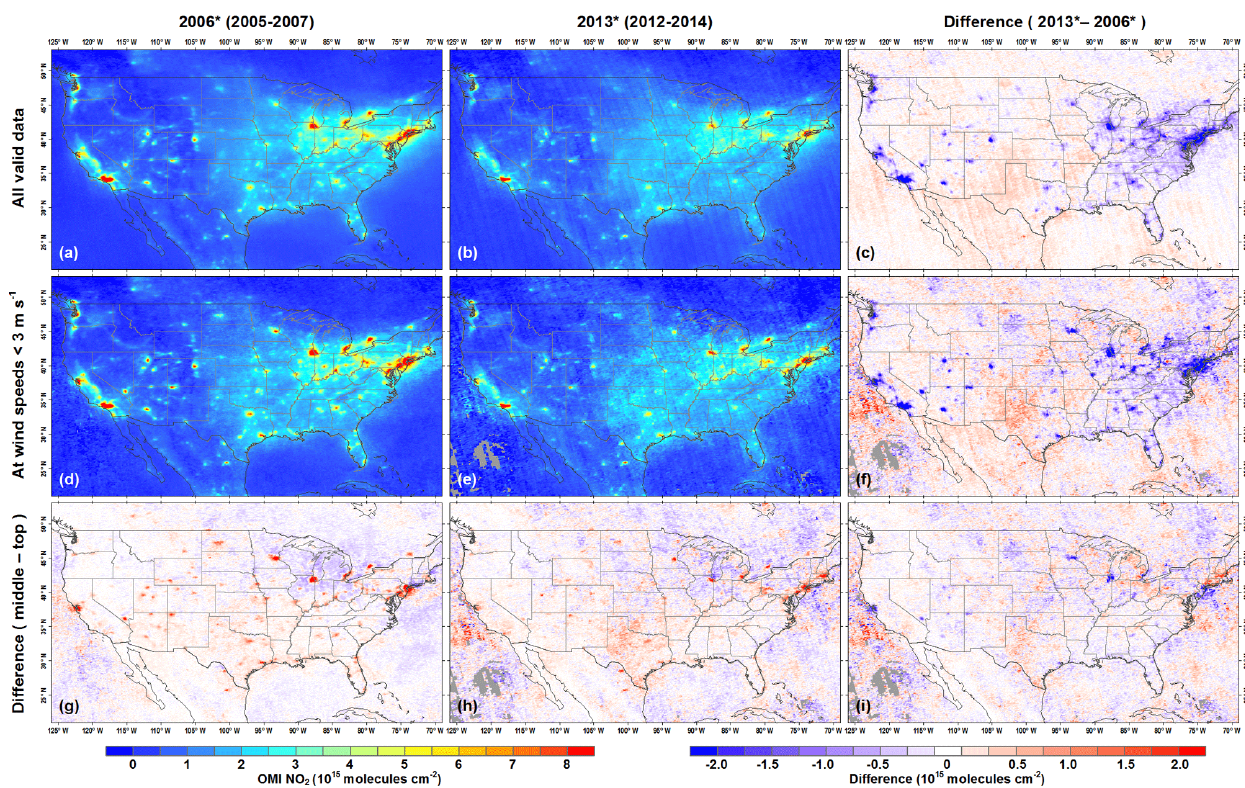
Figure 3. Average summer half-year (i.e., April to September) OMI NO 2 TVCDs over the continental US for (a, d) 2006* (i.e., 2005–2007) and (b, e) 2013* (i.e., 2012–2014): (a, b) all valid data were used, (d, e) only valid data with wind speeds <3ms − 1 were used. The right column shows the differences in maps between the middle and the left column. The bottom row shows the differences in maps between the middle and the top